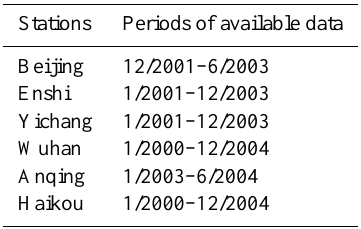
Fig. 1. Geographic locations of the radiosonde stations. Table 1. Periods of available data set for each radiosonde